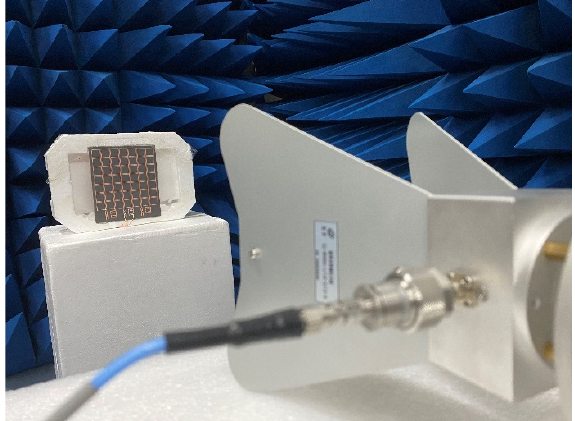
Figure 11. Fabricated metasurface array with integrated rectifier.